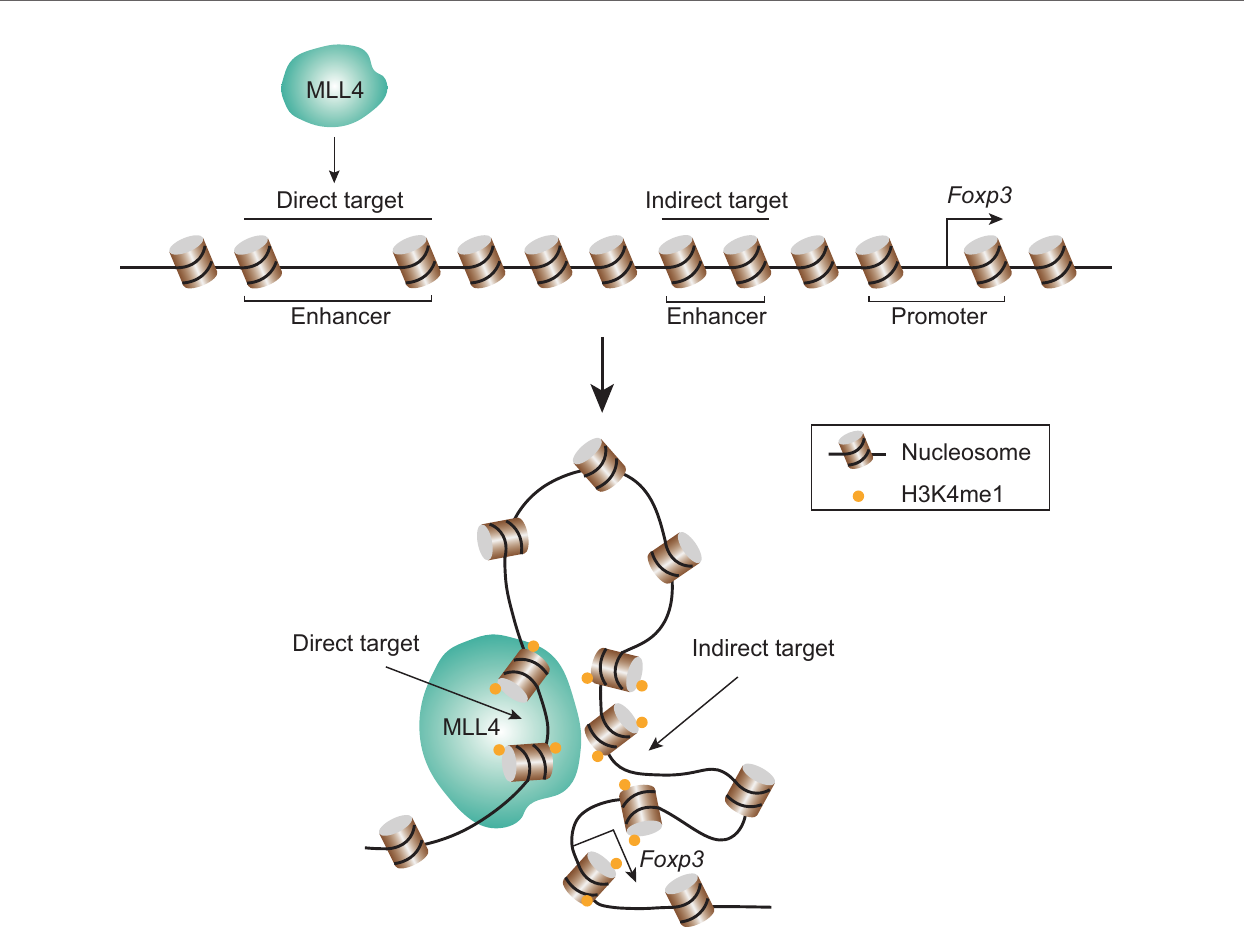
FIGURE 4 | MLL4 catalyzes H3K4 methylation through chromatin looping. MLL4 binds its direct target region, and the lysine 4 of histone H3 at distal indirect target regions are also methylated through chromatin